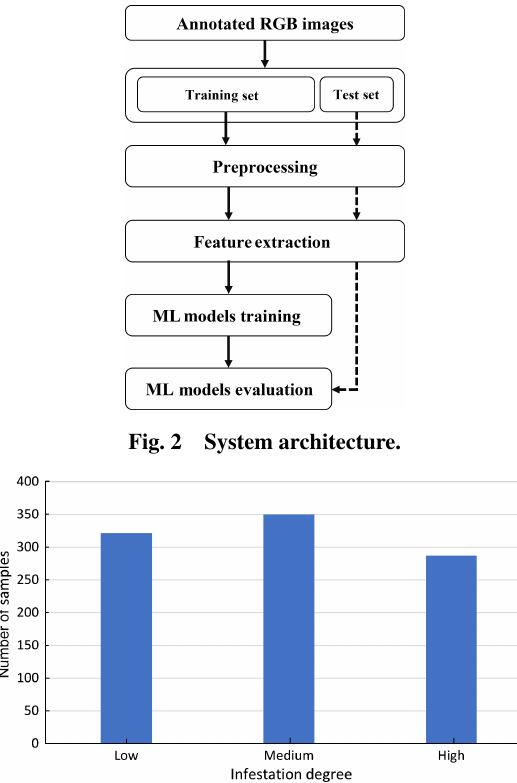
Fig. 3 Initial number of samples per infestation